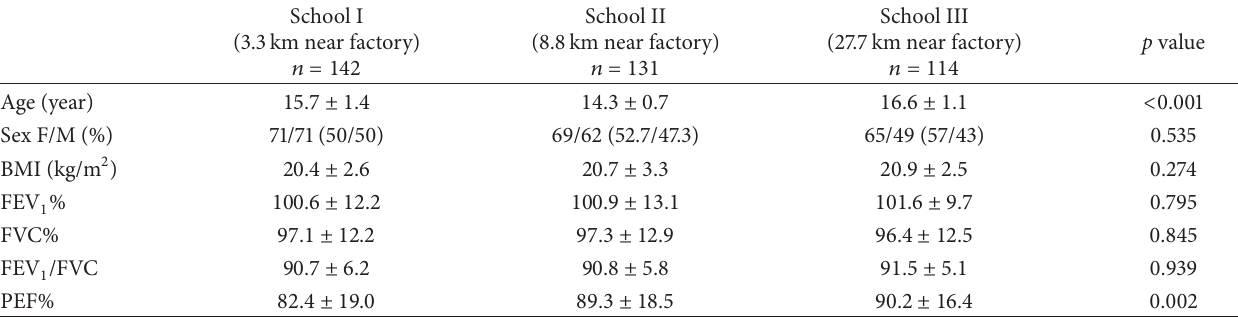
Table 1: Characteristics of patients included in the study.